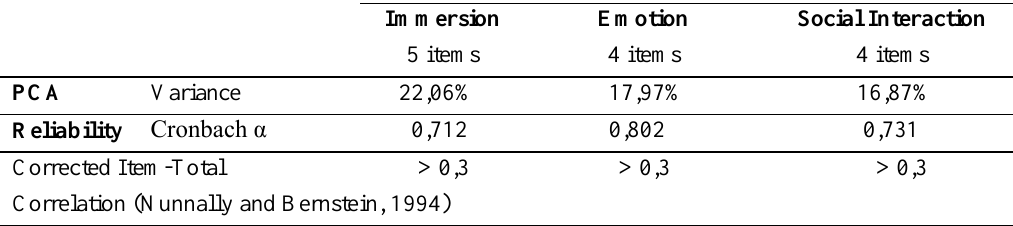
Table 1: Reliability of Measurement